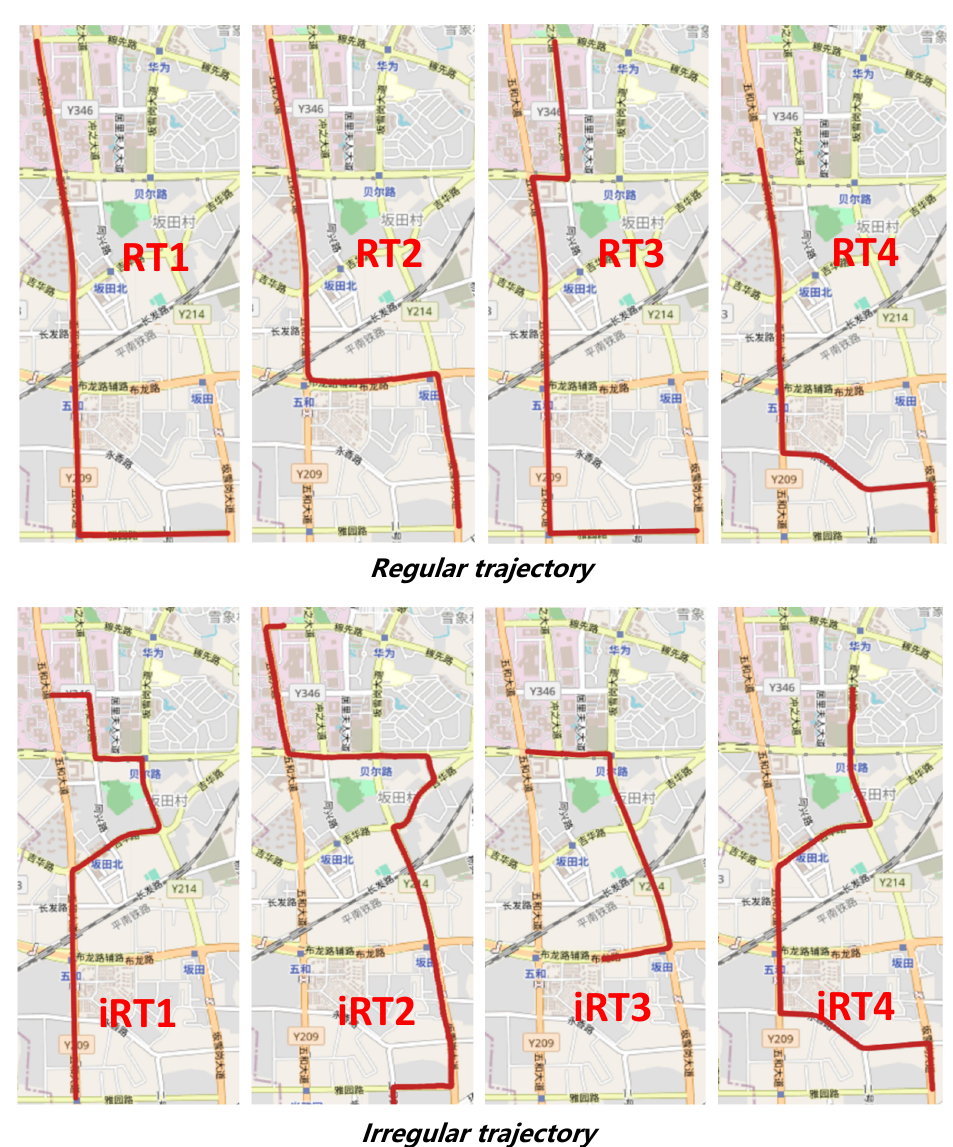
Figure 19. Regular trajectory (RT) and irregular trajectory (iRT).